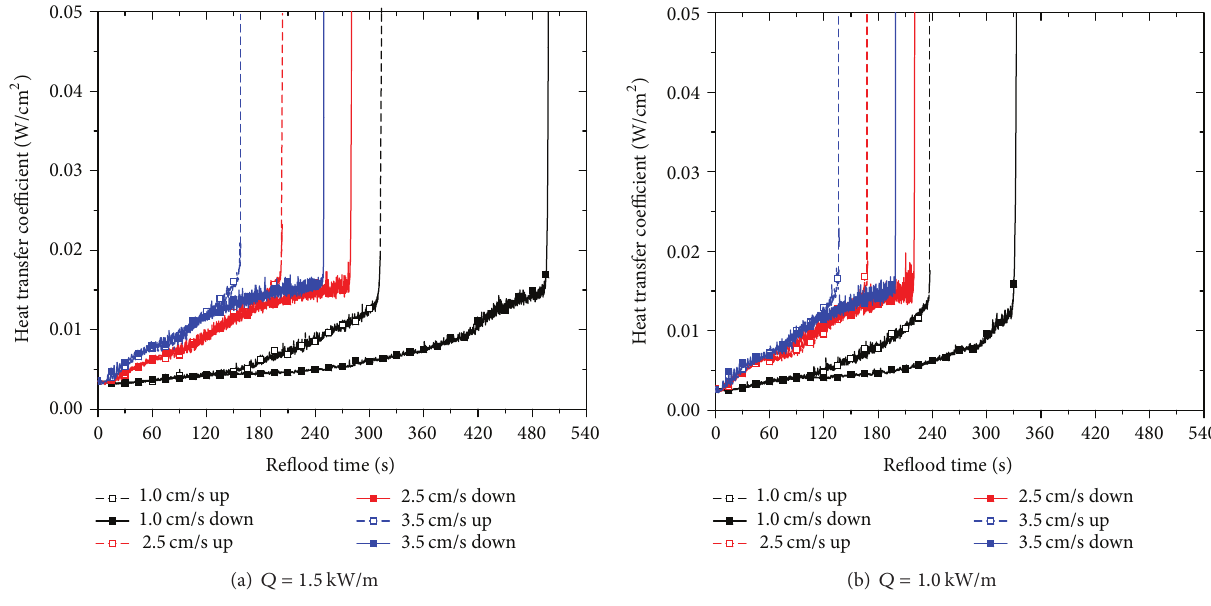
Figure 10: Comparison of the heat transfer coefficients distributions.